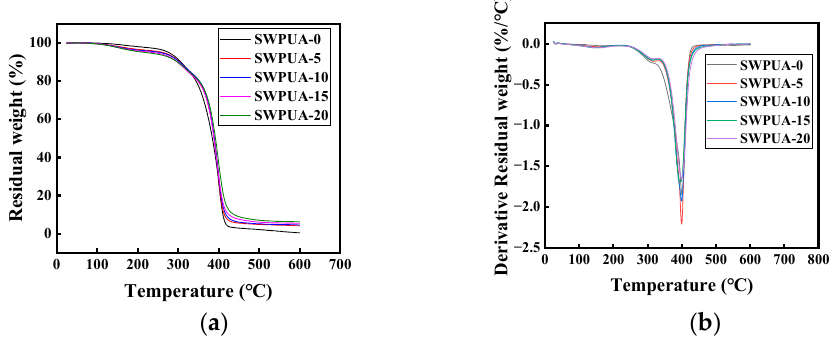
Figure 7. ( a ) Weight loss curves of SWPUA samples with di ff erent silicon content; ( b ) Derivative of weight loss curves of SWPUA samples with di ff erent silicon content.